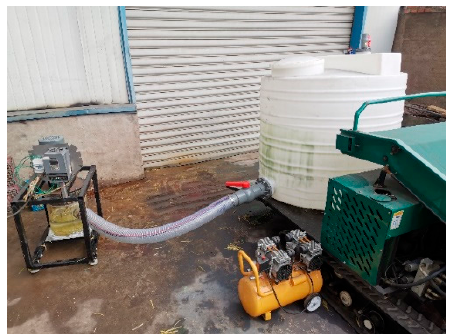
Figure 16. Digital image of bench test.